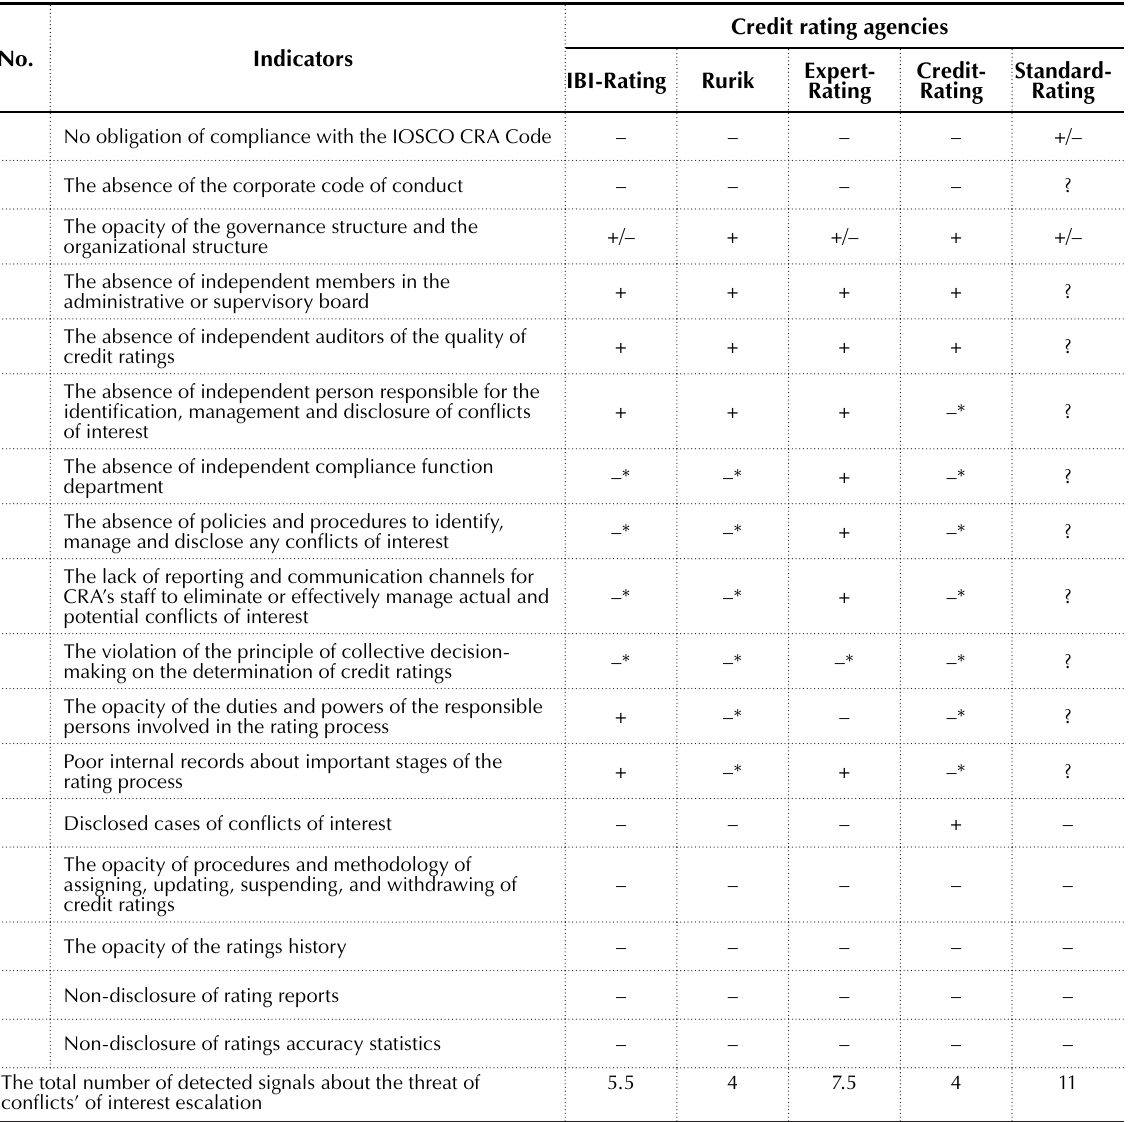
Table 4. The warning signals concerning the potential of conflicts of interest in models of corporate governance and organizational structures of CRAs in Ukraine